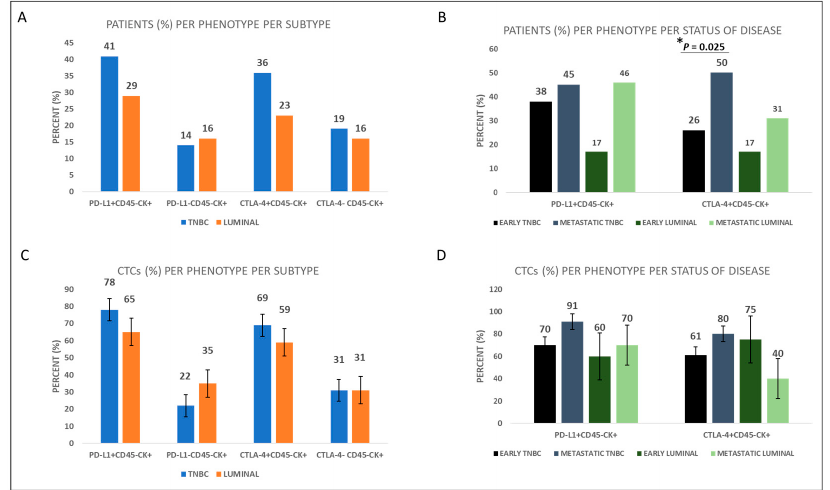
Figure 4. PD-L1 and CTLA-4 expression in BC patients’ CTCs. ( A ) Percentage of TNBC and luminal patients with PD-L1 + CD45 − CK + , PD-L1 − CD45 − CK + , CTLA-4 + CD45 − CK + , and CTLA-4 − CD45 − CK + phenotypes. ( B ) Percentage of early and metastatic BC patients with the corresponding CTC phenotypes (* p = 0.025). ( C ) Percentage of CTCs with PD-L1 + CD45 − CK + , PD-L1 − CD45 − CK + , CTLA-4 + CD45 − CK + , and CTLA-4 − CD45 − CK + phenotypes in TNBC and luminal patients. ( D ) Percentage of CTCs with the corresponding phenotypes in early and metastatic BC patients.